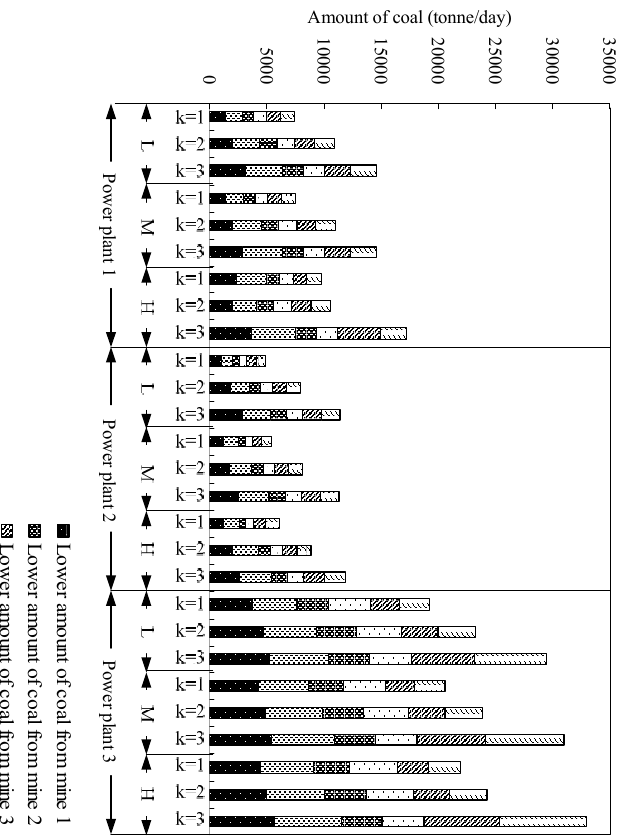
Figure 2. Optimum total coal flows to the power plants under scenarios 1 and